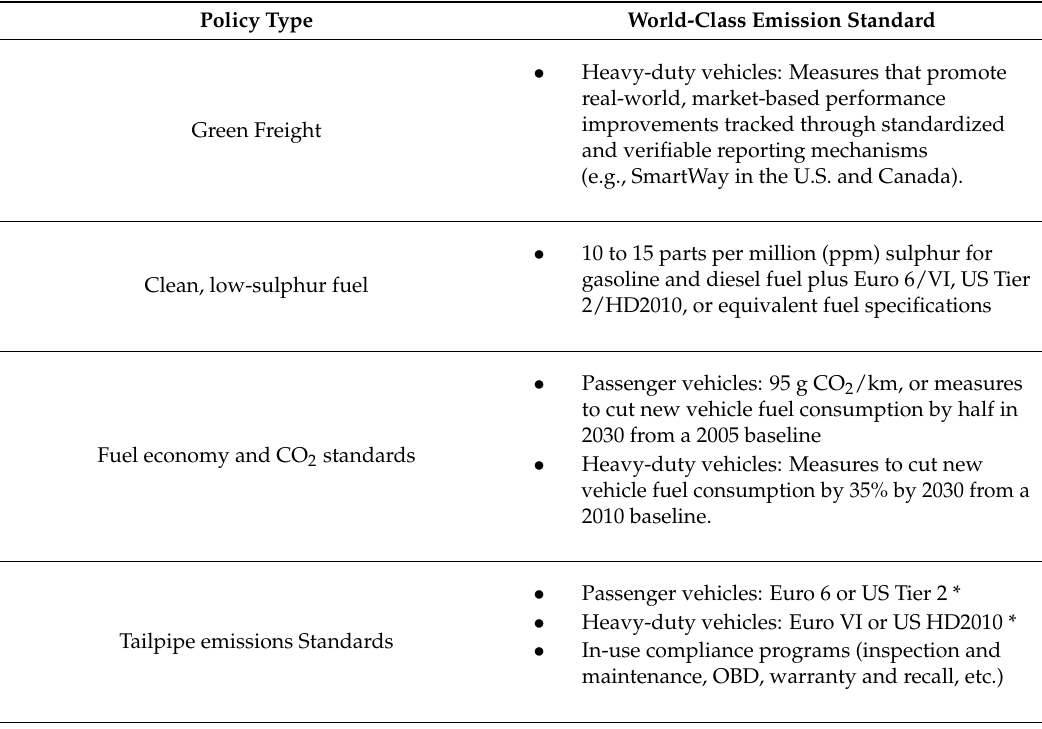
Table 1. Summarizes today’s world-class emission standards (with permission from